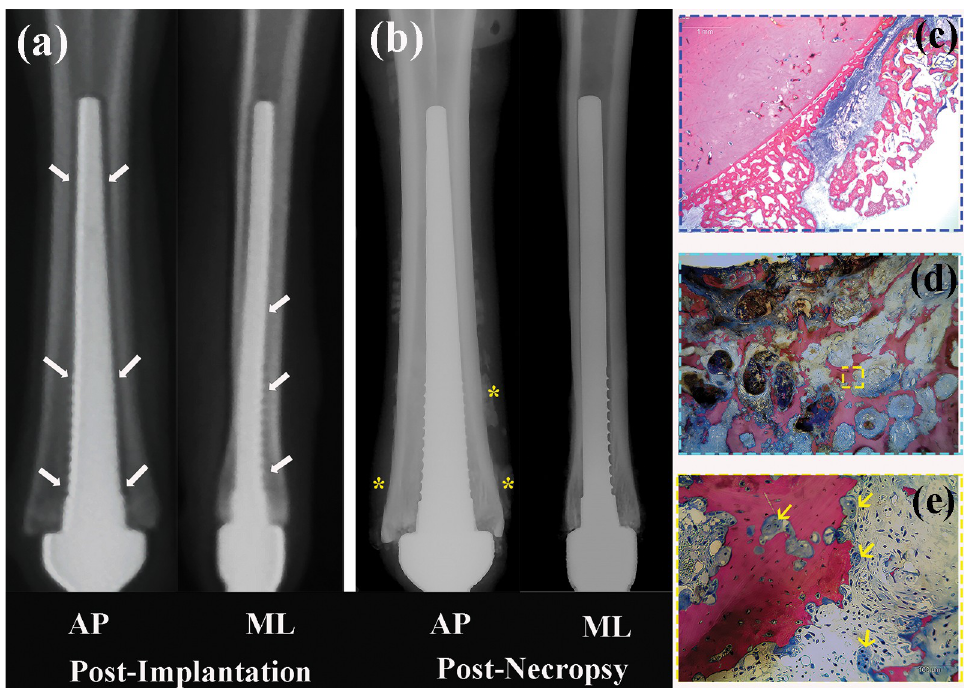
Fig 2. AP and ML radiographs of the metacarpal from the animal that developed clinical signs of infection ((a)—taken Post-Surgery and (b)–taken Post-Necropsy). Radiographs showed pronounced radiolucent zones medial, lateral and anterior to the endoprosthetic device (white arrows) and show periosteal reactive bone responses ( � ), a common sign of infection. Subsequent histological imaging verified a sub-periosteal infection (cross-sections stained with Sanderson Rapid Bone stain ((c), (d), and (e)); Pink-mineralized tissue and blue-fibrous tissue). Woven-bone exiting the periosteal surface is the reactive bone formation equivalent to sequestrum formation seen in the presence of chronic infection. Yellow arrows point to osteoclasts.